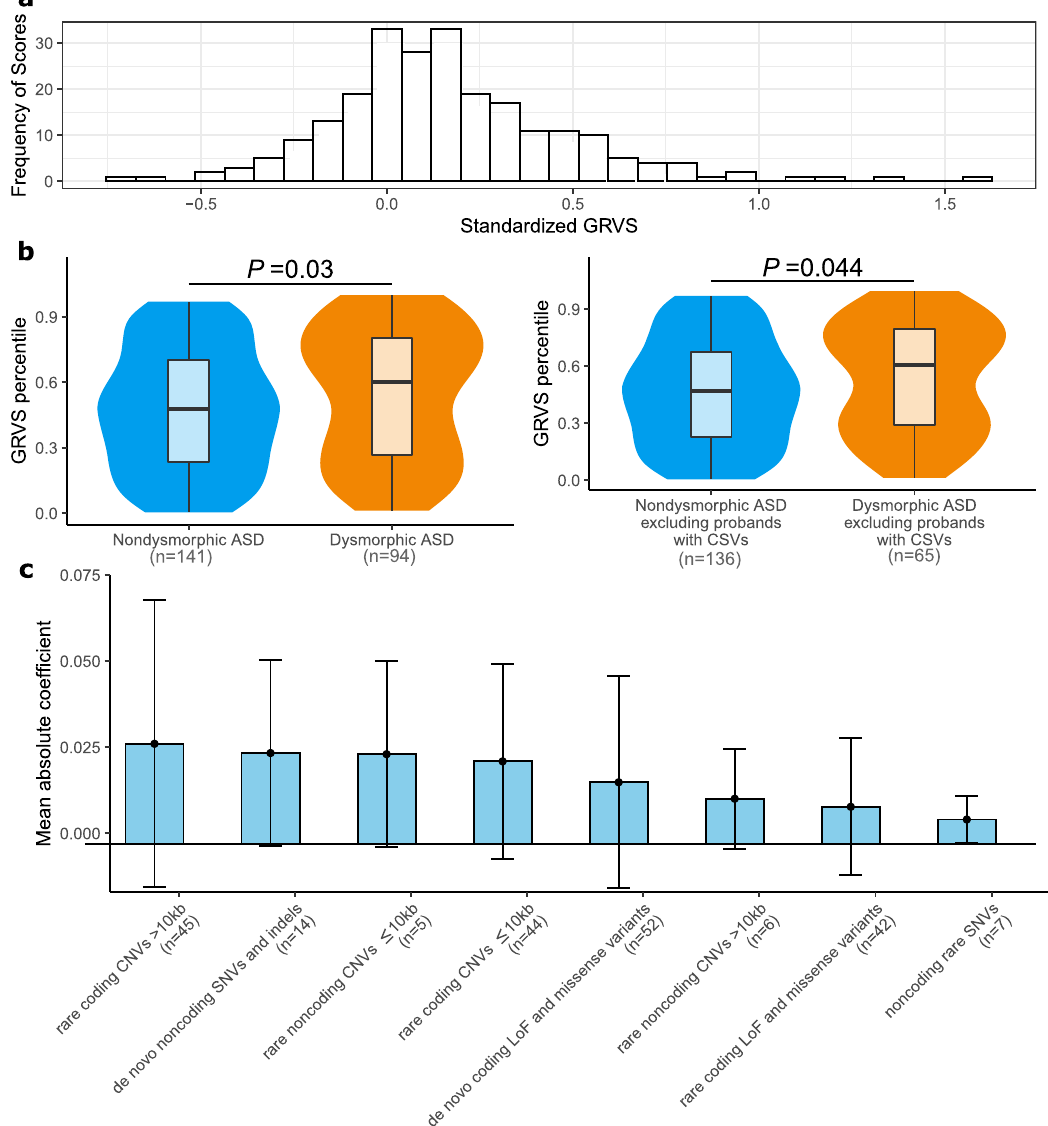
Fig.3|Genome-widerarevariantscoreinASDsubtypes. Eventsarecomprisedof variantsforSNVsandindelsorgenesimpactedbyCNVs.Foreachsample,theGRVS is the sum of rareand denovo events inmorphology-associated regions, weighted byeffectsize(estimatedfromthecoef fi cientsintheregressionmodel).GRVSswere generated30timesforeachsample(see “ Methods ” ),yieldinganaveragescoreand average number of variants. CSVs, clinically signi fi cant variants. a Distribution of standardizedGRVSforthediscoverycohort( n =235). b GRVSsforthewholecohort (left plot, n =235) or the whole cohort excluding the 17 probands with clinically signi fi cant variants (right plot, n =218), were ordered and ranked by percentile. Note that while 46 probands in the discovery cohort ( n =325) had CVSs, only 17 of them had two sequenced parents meeting inclusion criterion for the GRVS group ( n =235). The minima and maxima of box plots indicate 3× the interquartilerange-